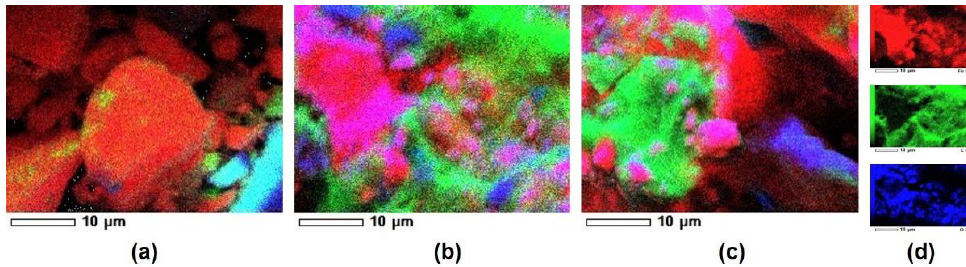
Figure 6. Elemental mapping of C-element: ( a ) dehydrated ore, ( b ) Sample D1, ( c ) Sample D2, and ( d ) red, green, and blue areas corresponding to Fe-, C-, and O-elements, respectively.